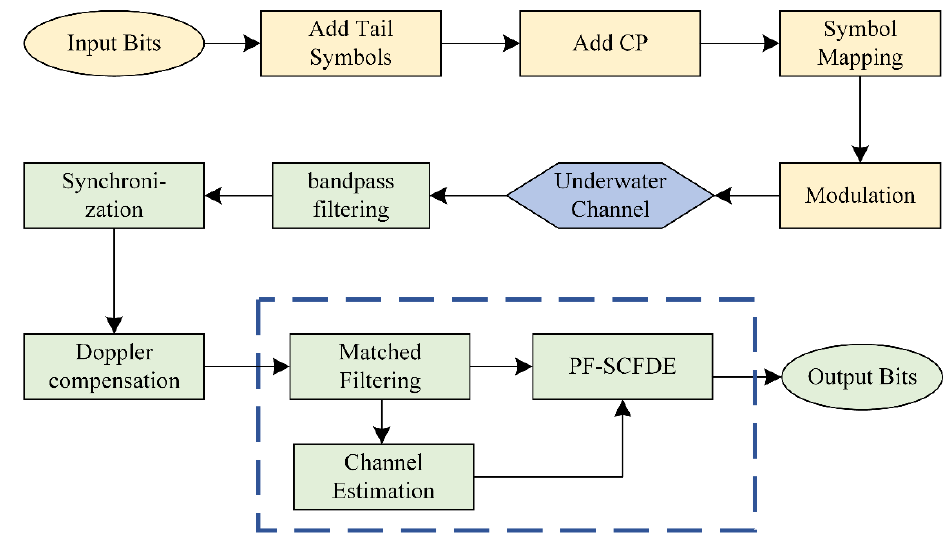
Figure 1. Block diagram of the CPM with the PF-SCFDE UWA communication system.